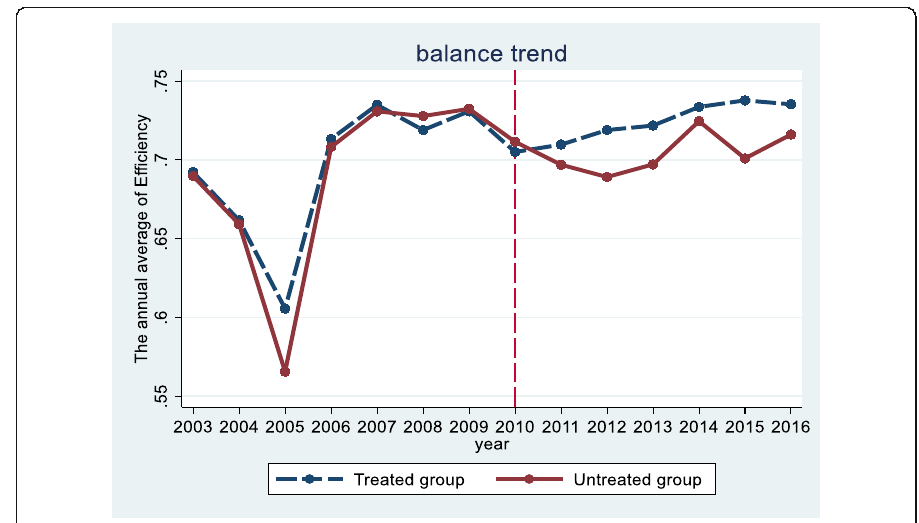
Fig. 1 Time trend of Efficiency between treated group and untreated group